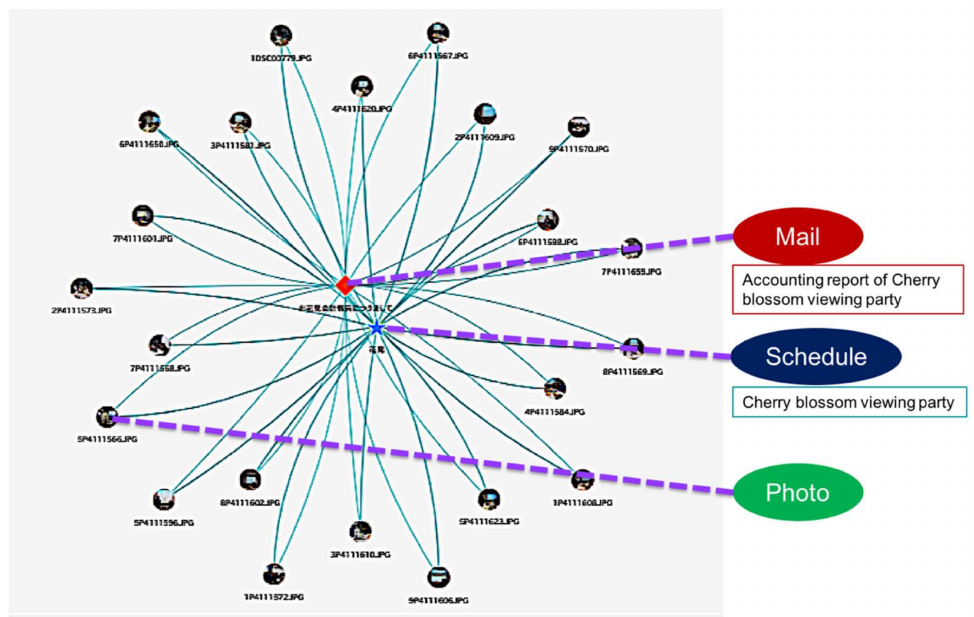
Figure 10. Presentation results of the memory fragments from one day of user experience generated as AIRs.